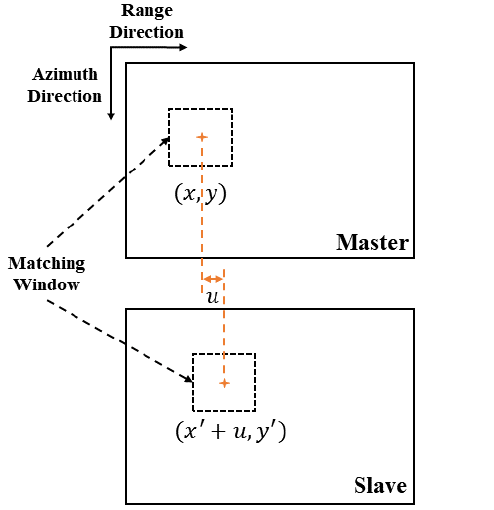
Figure 3. The illustration of the calculation of the cross-correction